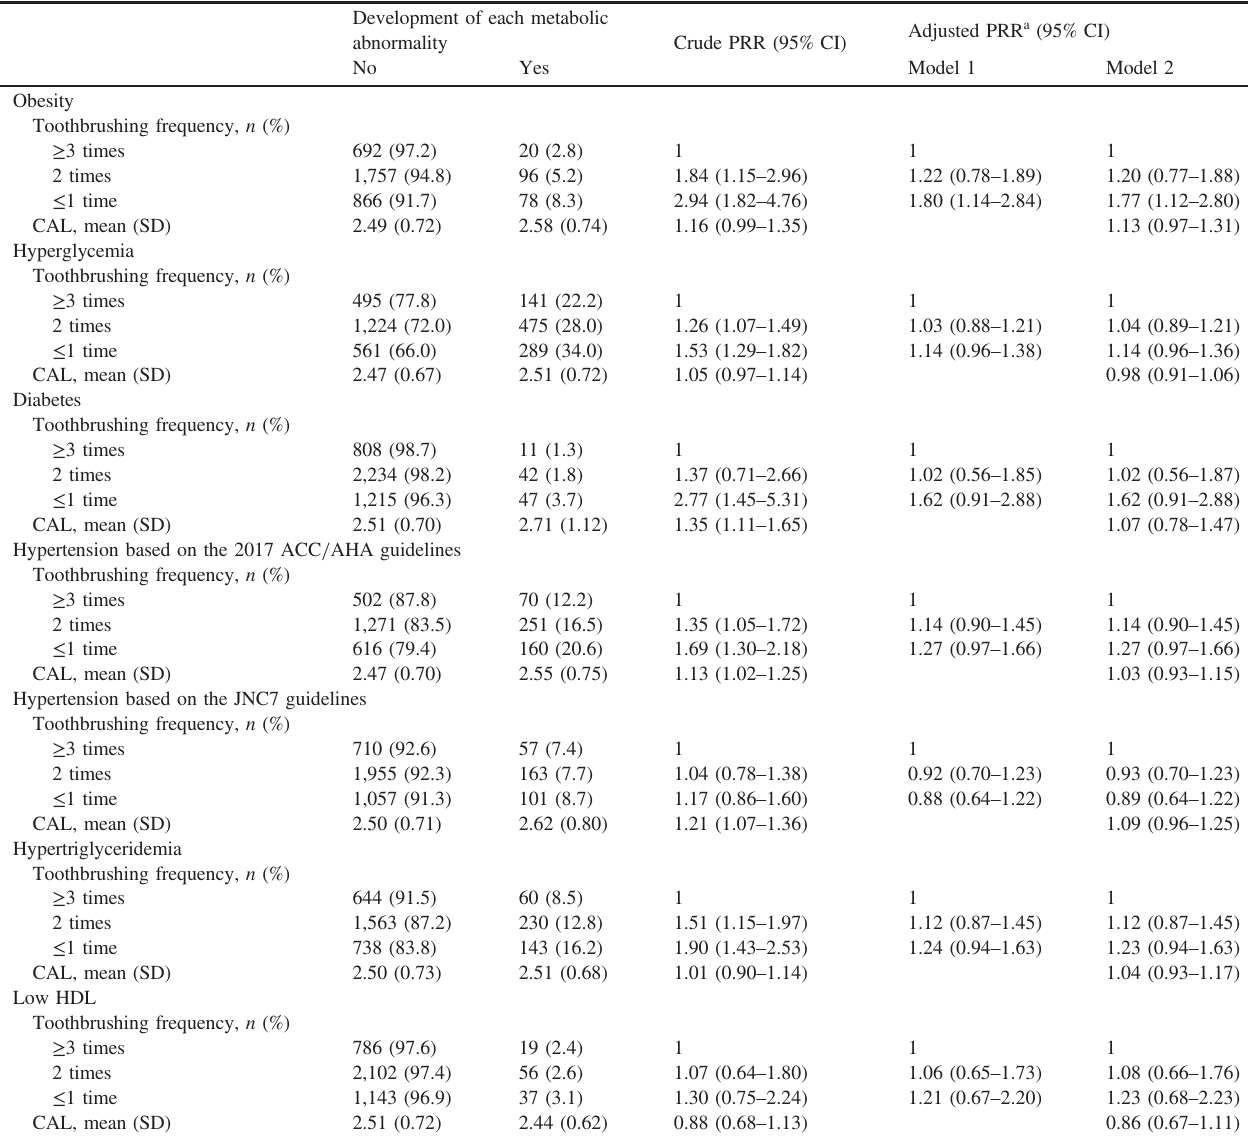
Table 5. Association between toothbrushing frequency and the development of each metabolic abnormality Development of each metabolic abnormality Crude PRR (95%